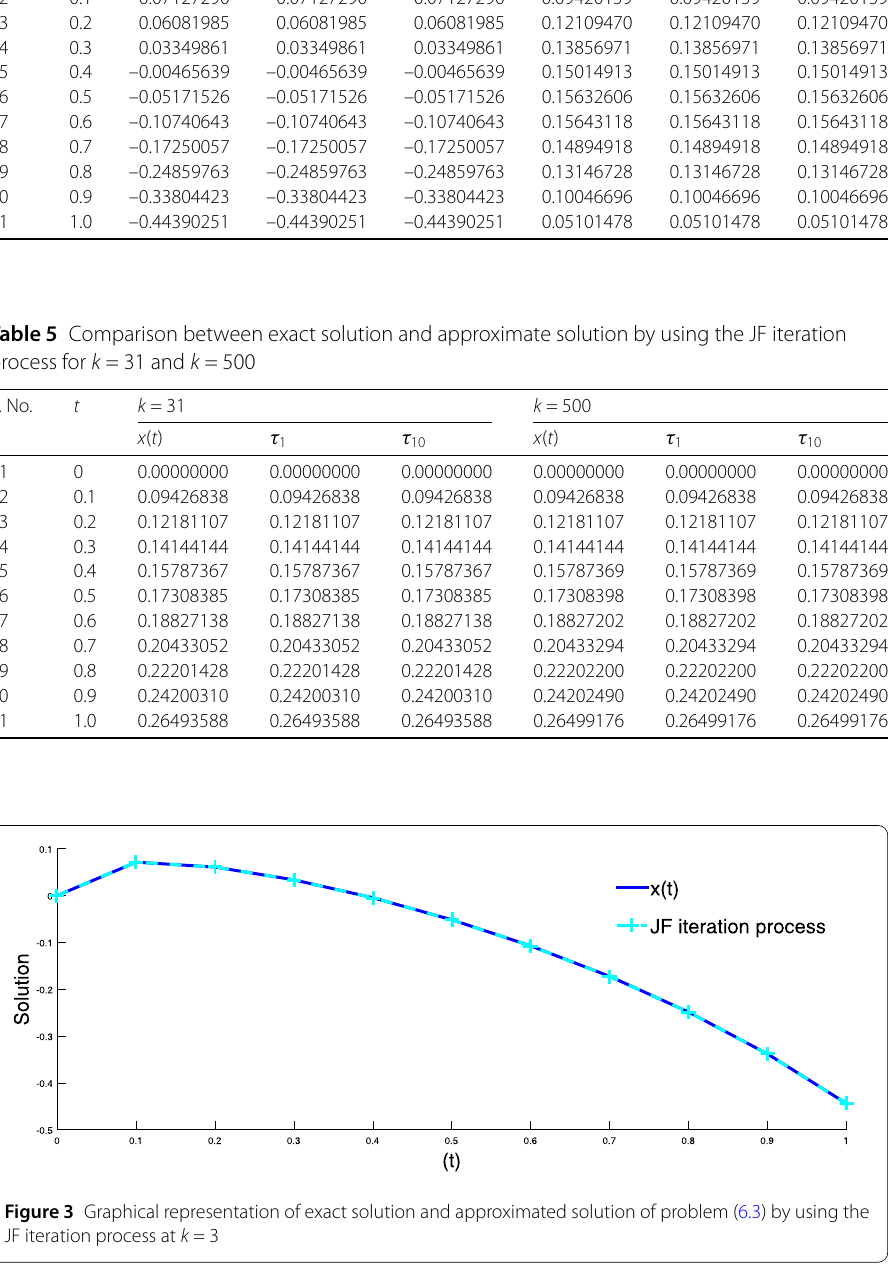
and show that JF iteration process converges to the solution of fractional differential equa- tion. We also observe that the behavior of JF iteration process will remain identical after k =